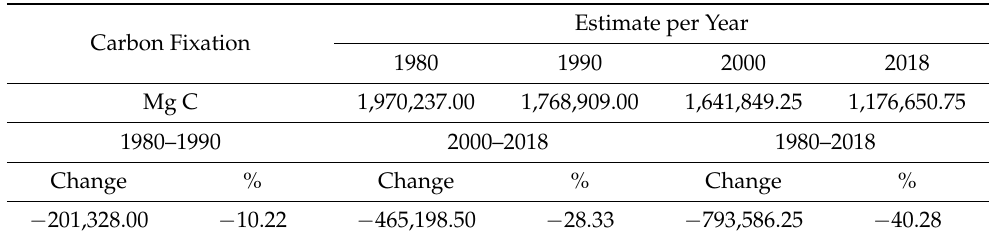
Table 6. Change in Carbon Fixation from